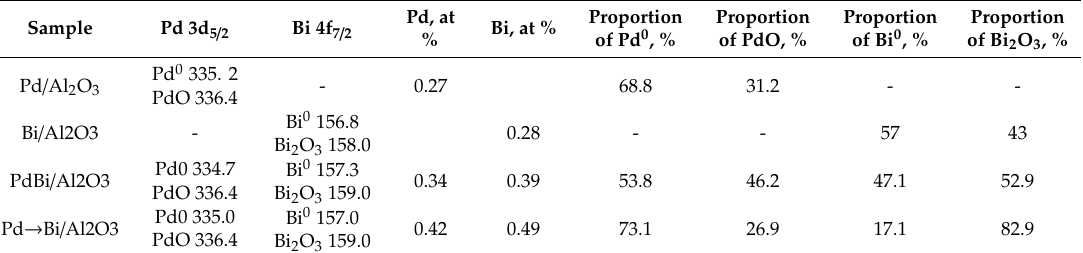
Figure 7. X-ray photoelectron spectra of sample surfaces of catalysts ( a ) Pd 3d, ( b ) Bi 4f. Table 3. Binding energy (eV), atomic percent Pd, Bi and a proportion of metallic and oxide phases of catalyst samples for binding energies of Pd 3d 5 / 2 and Bi 4f 7 / 2